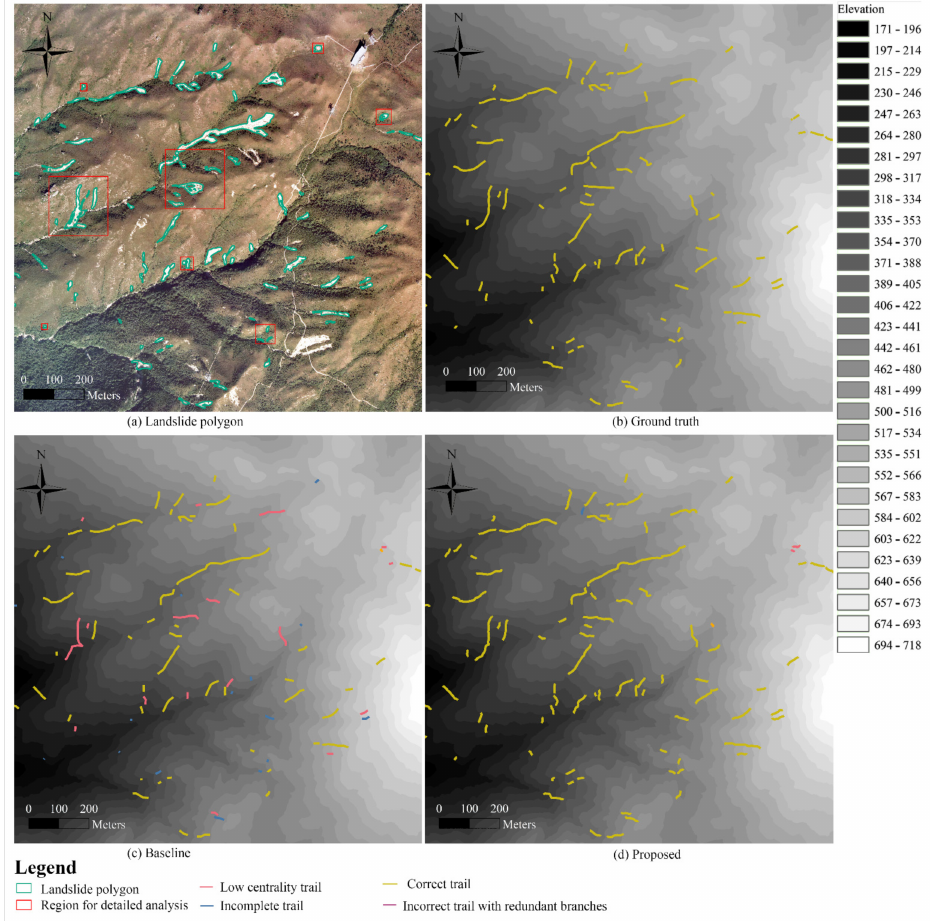
Figure 14. Landslide trail extraction result for the study area B. ( a ) Landslide polygon overlaid on aerial photo; ( b ) landslide trails ground truth; landslide trail result obtained by ( c ) the baseline method and ( d ) the proposed method. All extraction results are overlaid on DEM. The red boxes in ( a ) indicate several sub-regions used for more detailed